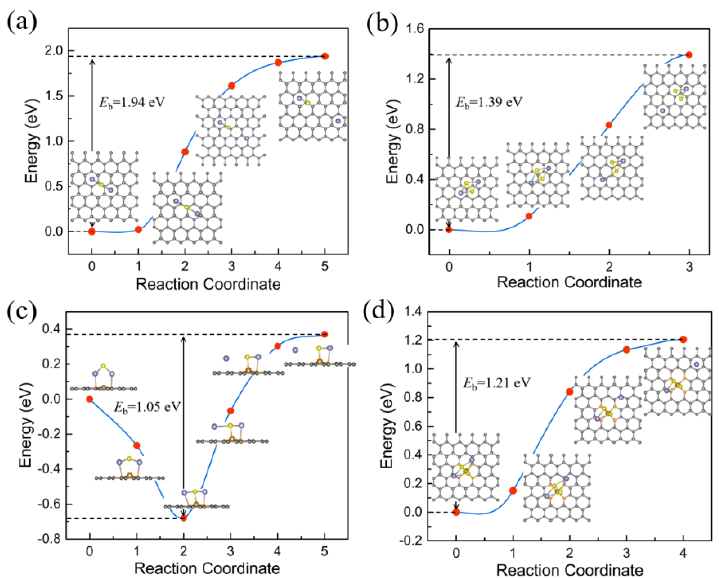
Figure 6. Decomposition pathways and corresponding energy barriers for Na 2 S and Na 2 S 2 on pristine graphene ( a , b ) and Fe-N 4 @graphene ( c , d ) surface, respectively. The insertions are the intermediate images of one Na ion departing from the NaS/NaS 2 cluster.